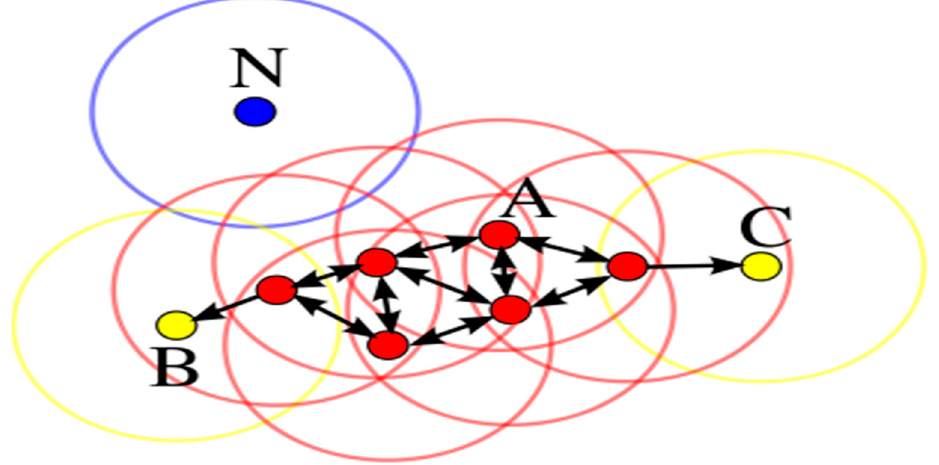
Figure 3. Red points are core points; points B and C in yellow are density-reachable, and point N in blue is a form of noise [62].